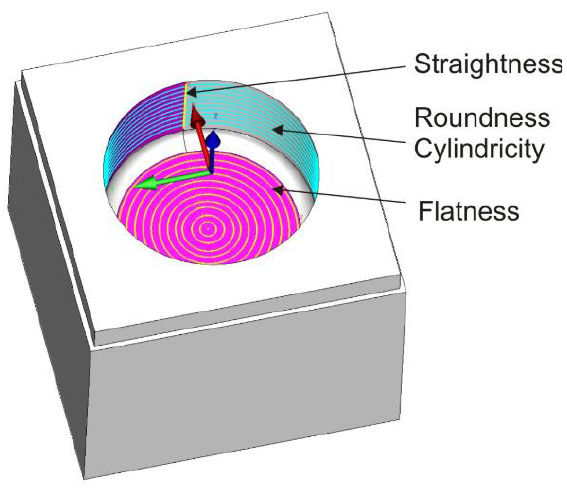
Figure 8. The individual measured areas and the evaluated characteristics. A measurement strategy using 4 line segments was chosen to evaluate the straight- ness of the cylindrical surface of the pocket. The start of the measurement was at a depth of 1.5 mm from the BS plane, and the end of the measurement was at 13.5 mm. A scanning strategy with a step size of 0.1 mm was used for the measurement, and the LSQ (least squares) method and Spline low-pass filter with wavelength L C = 2.5 mm were used for the evaluation without eliminating outliers. The location and indication of the individual lines for the directness evaluation are shown in Figure 9.